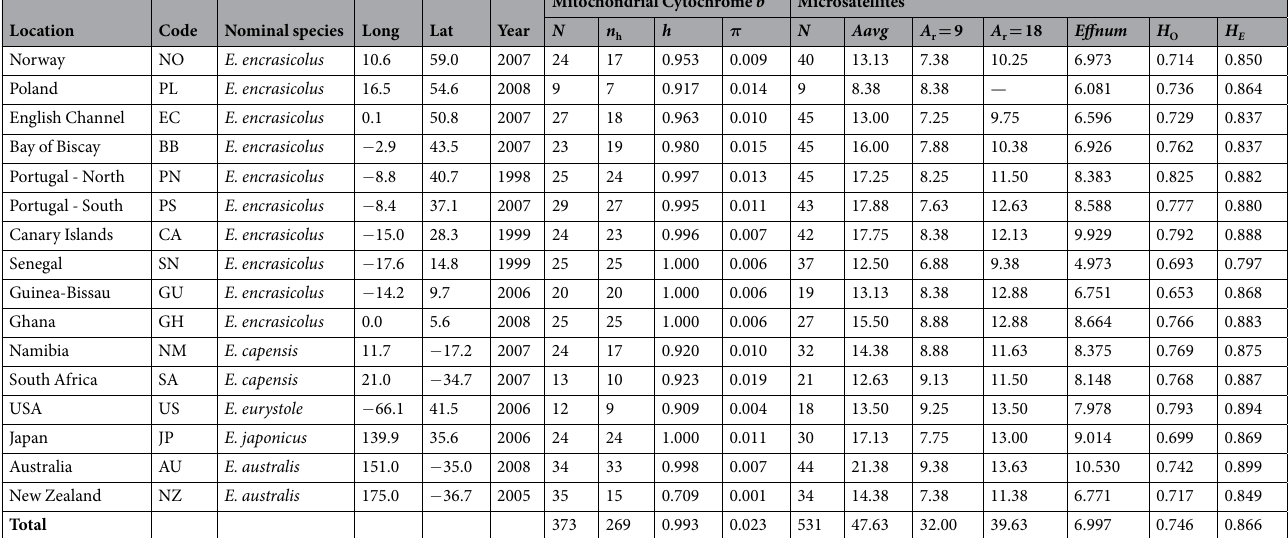
Table 1. Sample locations, sample abbreviations, collection dates, sample sizes and summary statistics for a 1044 bp sequence fragment of the mtDNA cytochrome b and eight nuclear microsatellites of Old World Anchovies (OWA). Long, longitude; Lat, latitude; N , number of individuals; n h , number of haplotypes; h , haplotype diverstity; π , nucleotide diversity; Aavg , average number of alleles, Ar , allelic richness; Effnum , Effective number of alleles; H 0 , observed mean heterozigozity; H E , expected mean heterozygozity.